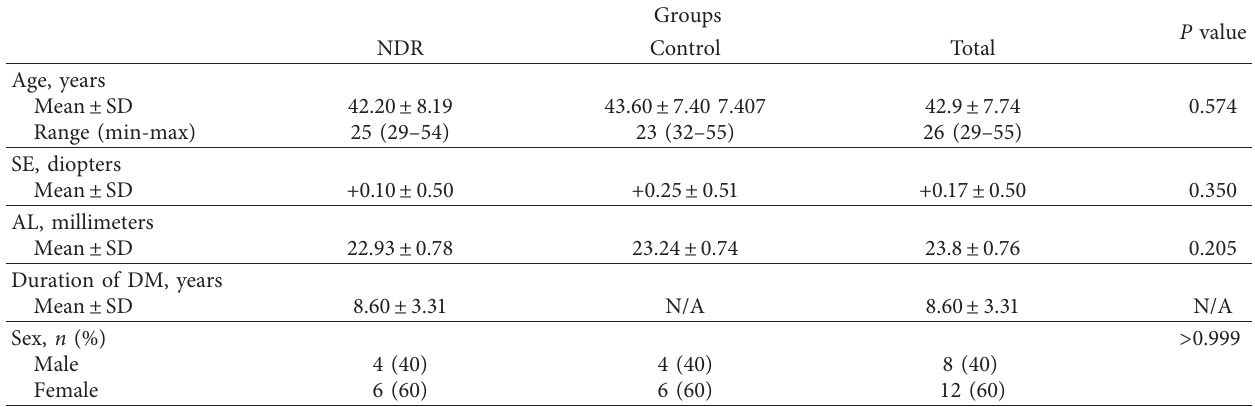
Table 1: Demographic characteristics of subjects.